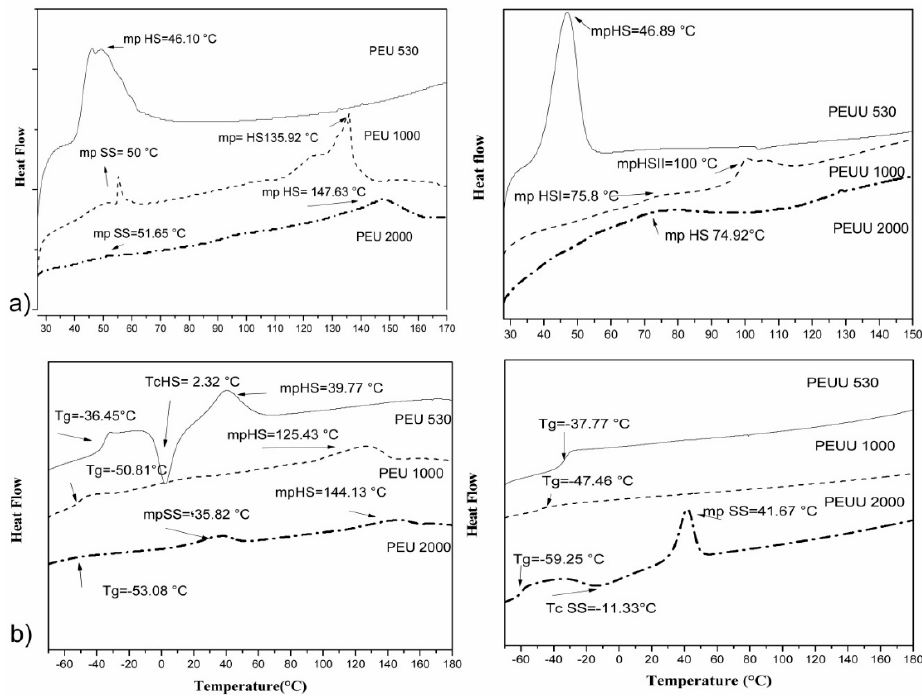
Figure 3. ( a ) First DSC run for the PEUs (left) and PEUUs (right), and ( b ) second DSC run for PEUs (left) and PEUUs (right).